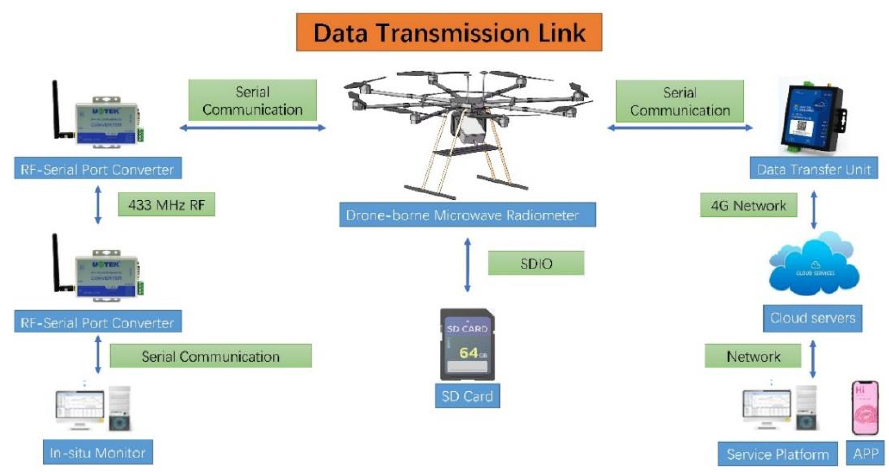
Figure 4. Data transmission link.